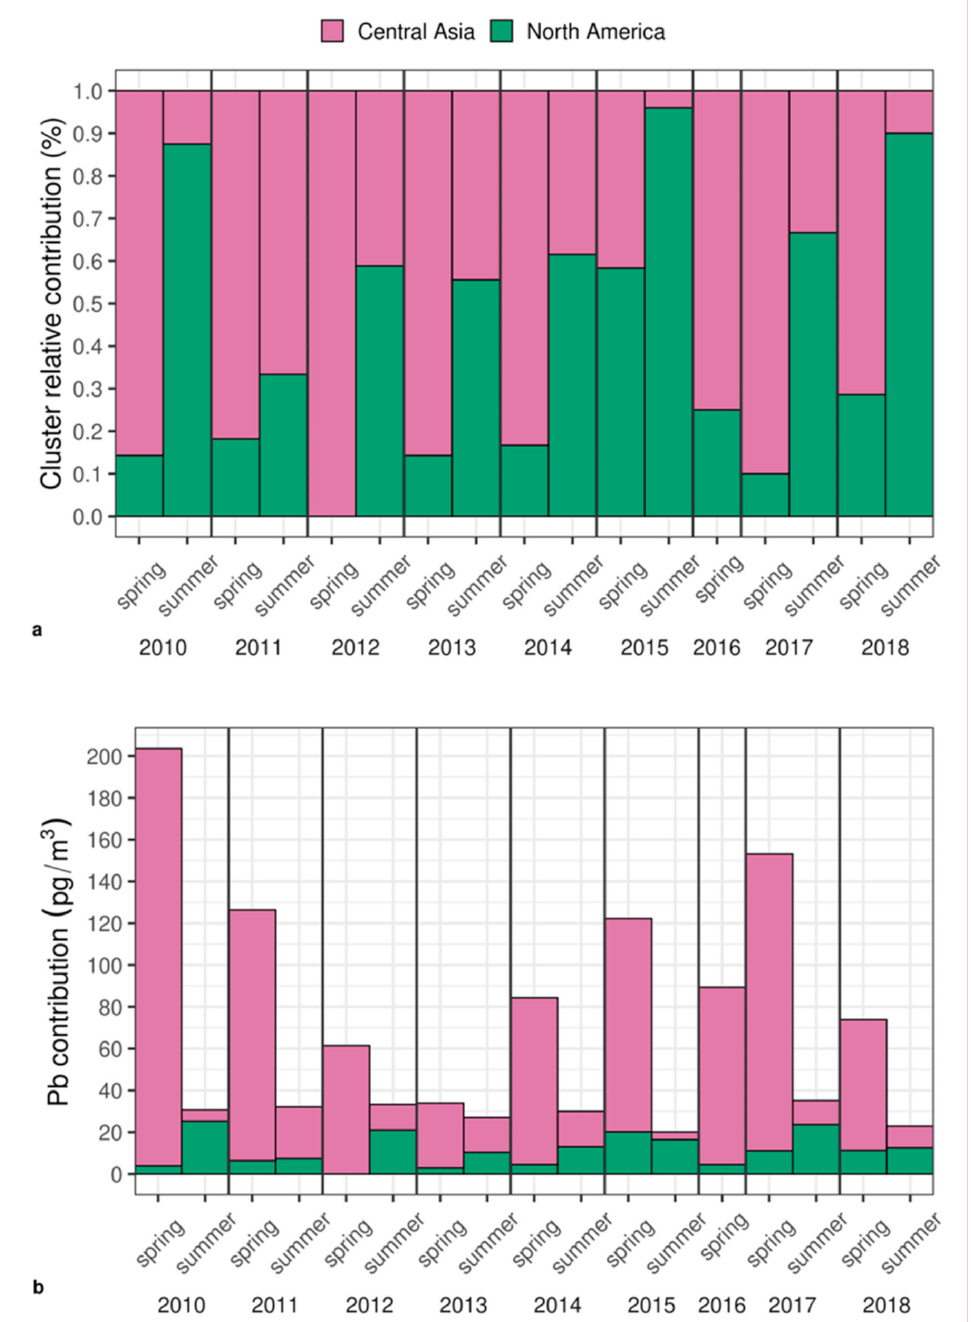
Figure 5. Spring and summer contributions from Central Asian and North American to anthro- pogenic atmospheric Pb measured in PM 10 samples collected at Ny-Ålesund from 2010 to 2018. ( a ) percentage of samples assigned to each possible source, ( b ) estimated Pb